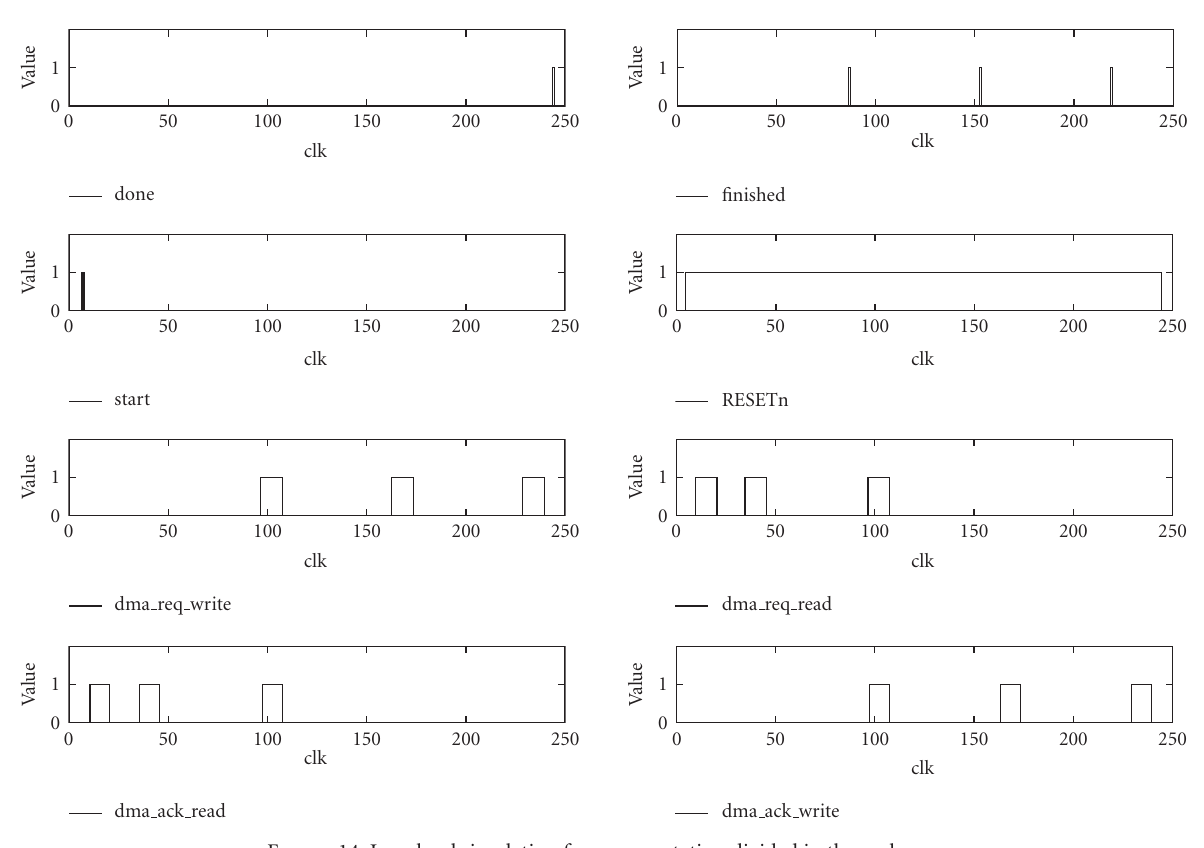
Figure 14: Low-level simulation for a computation divided in three phases.